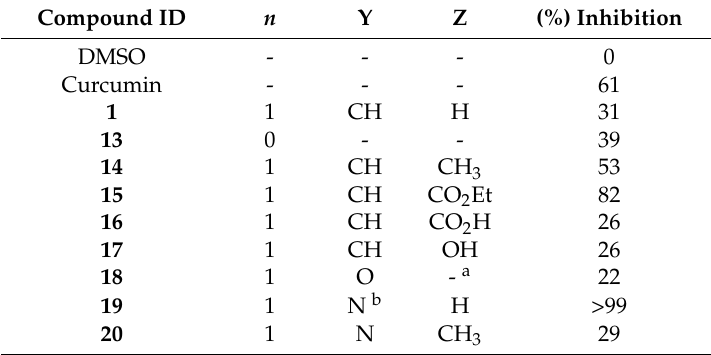
Table 2. Screening for identifying potent CBP HAT inhibitors by determining the percent inhibition in Dox-mediated activation of p53 response element in U2OS cells treated with 500 nM of cy - C 5 -curcuminoid analogs with central ring modifications.